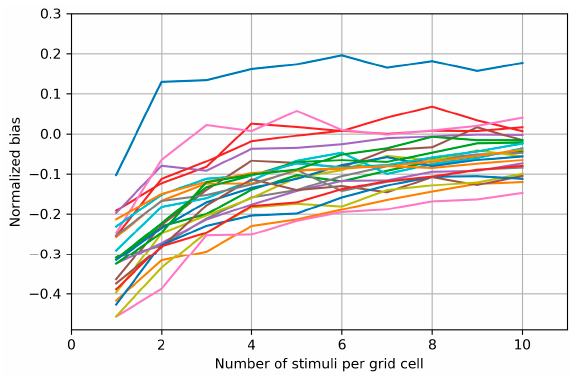
Figure A1. Bias of the area of the cells with a mean MEP above 50 µ V for each TMS map obtained in a